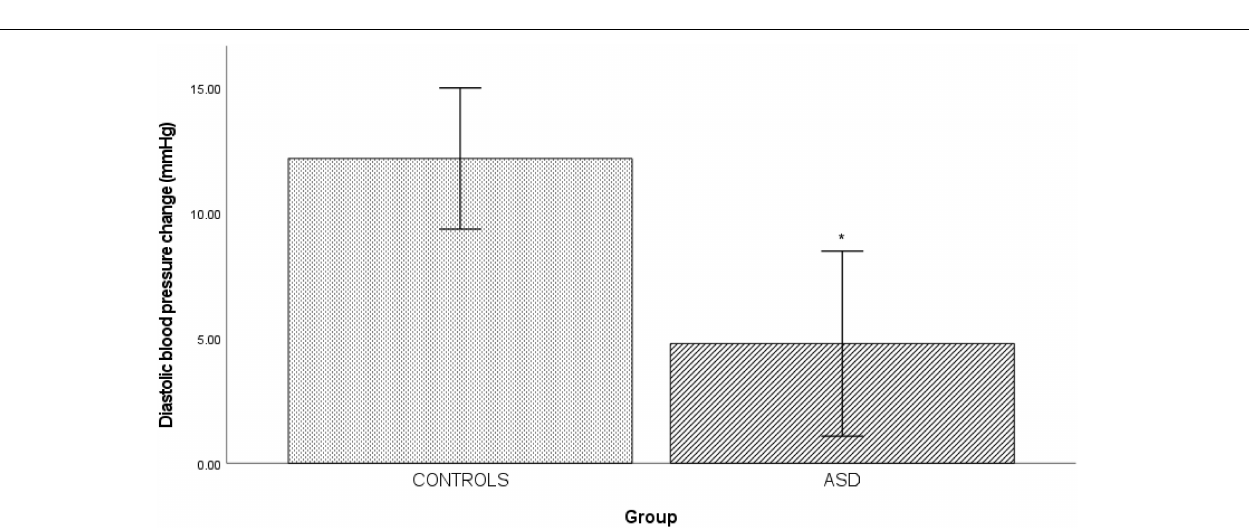
FIGURE 4 | Changes in mean diastolic blood pressure from baseline during cold pressor in controls and ASD. mmHg, millimeters of mercury. *Refer to a statistically significant